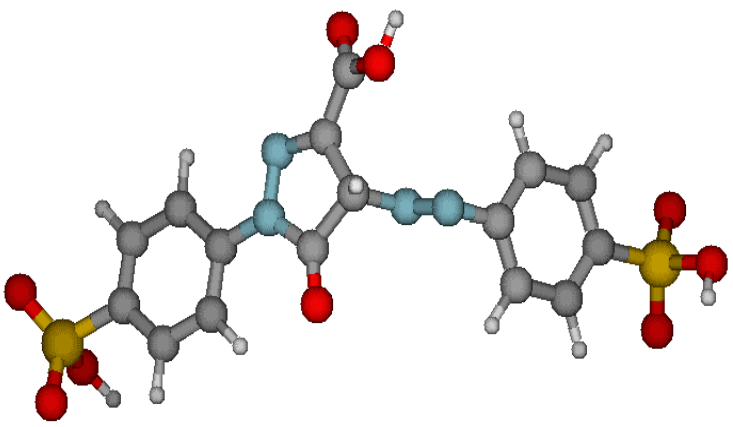
Figure 5. Ball and stick atomic model of Tartrazine.